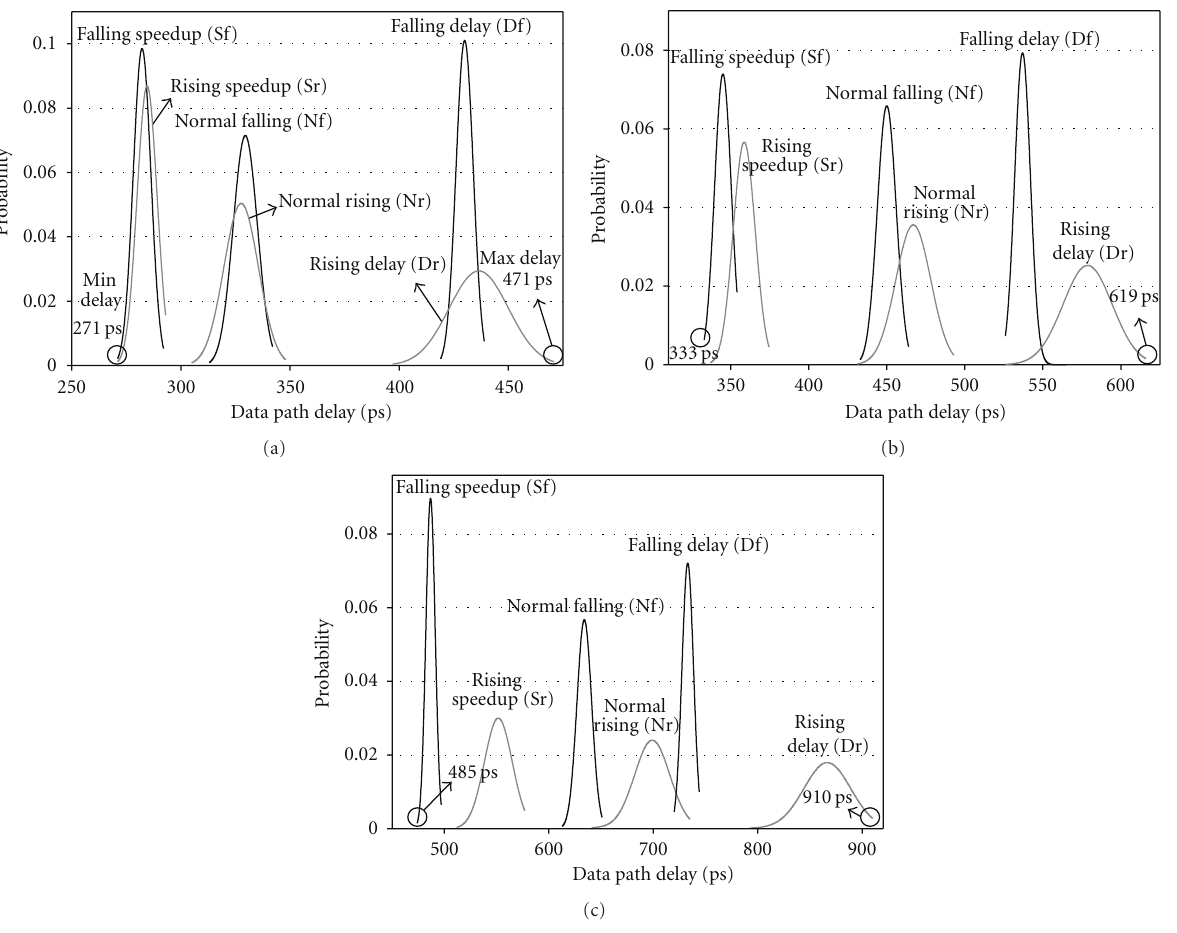
Figure 19: The data path delay ( t d ) distributions of rising speedup, falling speedup, rising delay, falling delay, normal rising, and normal falling cases under (a) high voltage (1.0V), (b) medium voltage (0.85V) and (c) low voltage